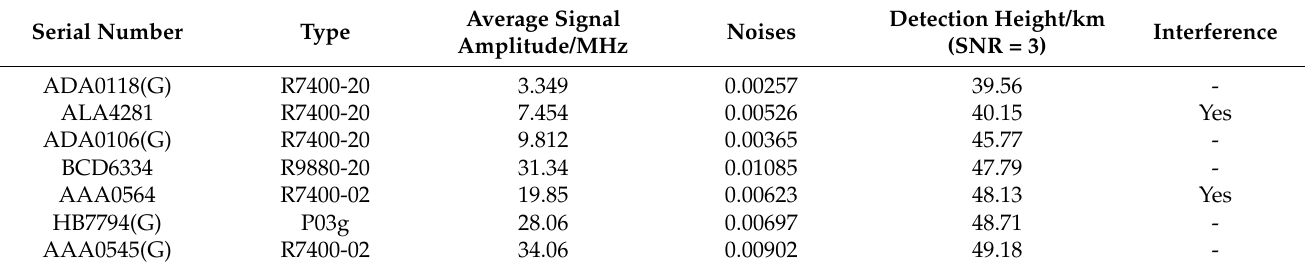
Table 7. Single channel test results for different models of